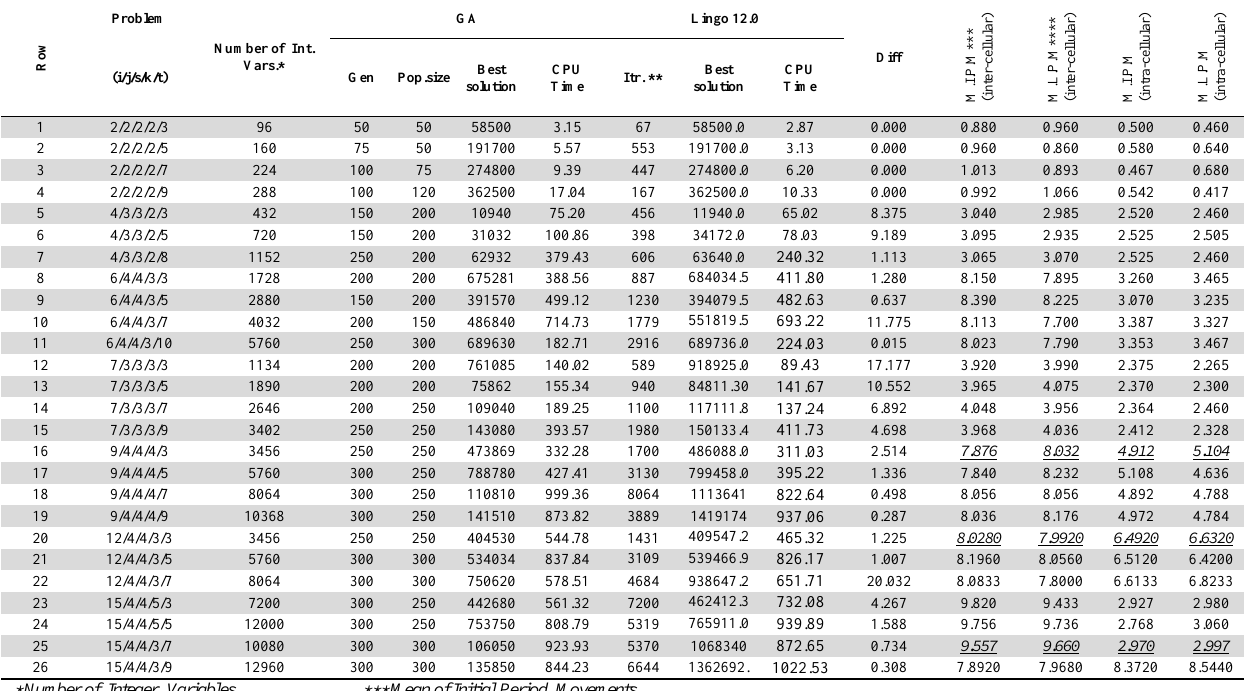
*Number of Integer Variables **Number of